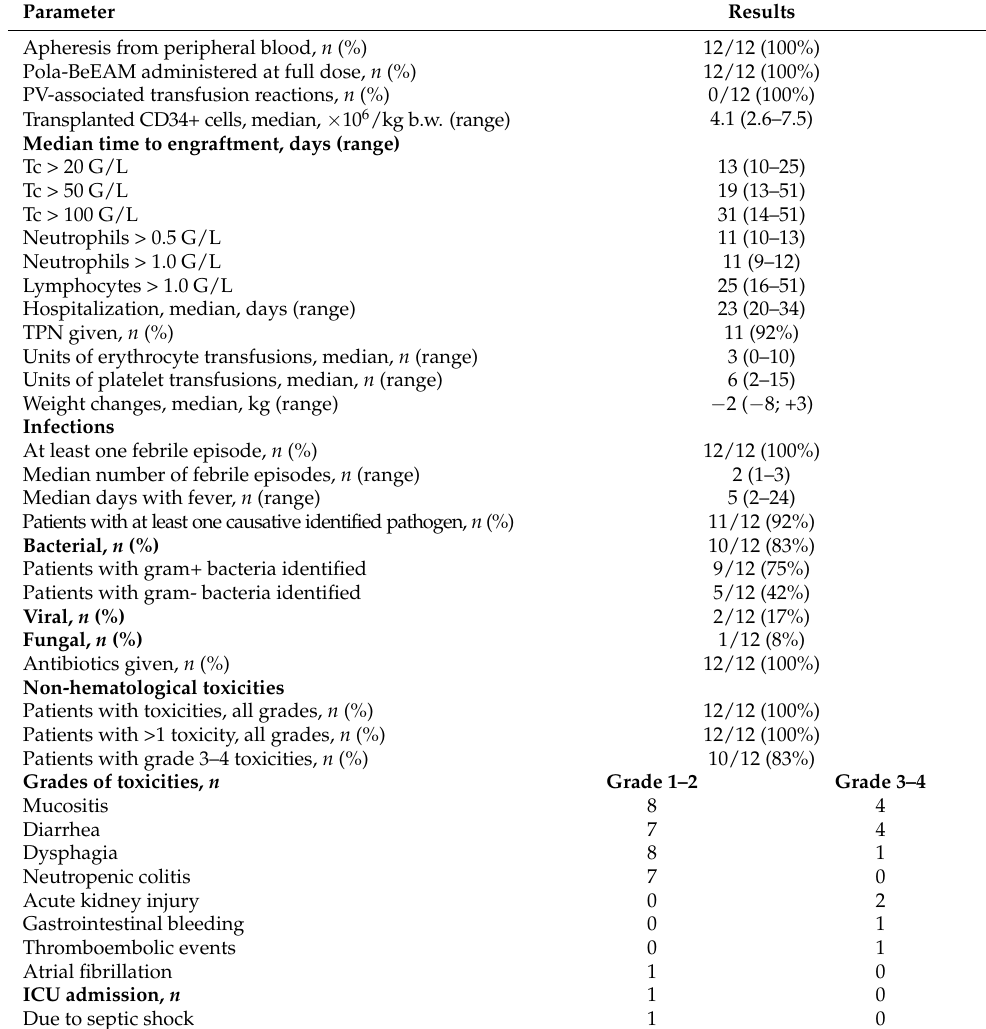
Table 3. Details of high-dose chemotherapy, engraftment, infections, and hematological- and non- hematological